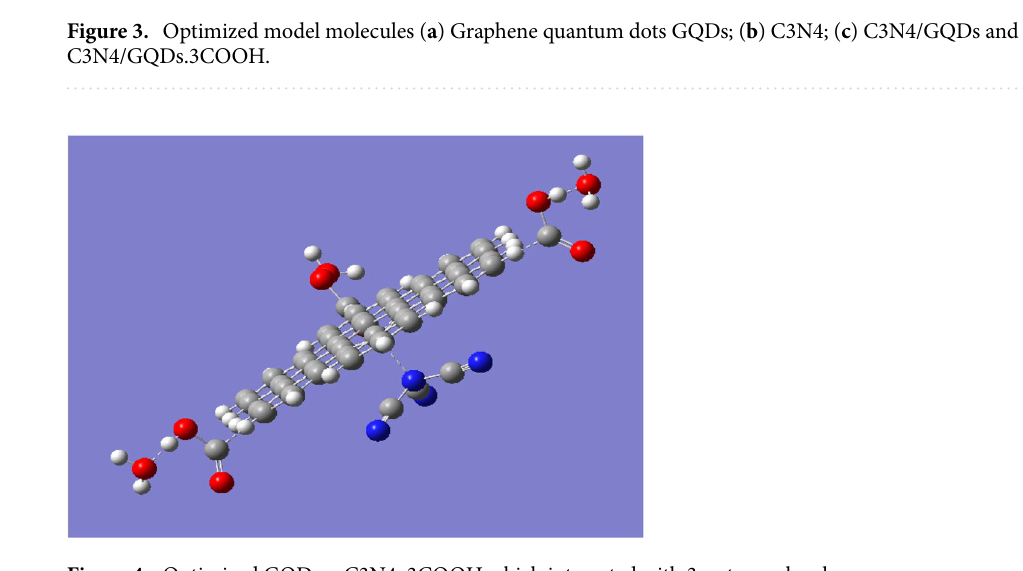
Figure 4. Optimized GQDs.g-C3N4. 3COOH which interacted with 3 water